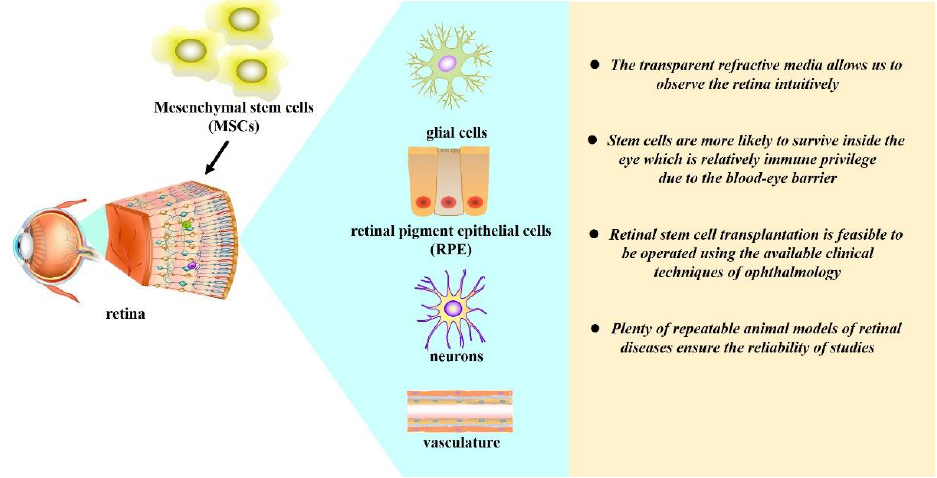
Figure 1. Retina is a suitable target for MSC-based therapy.